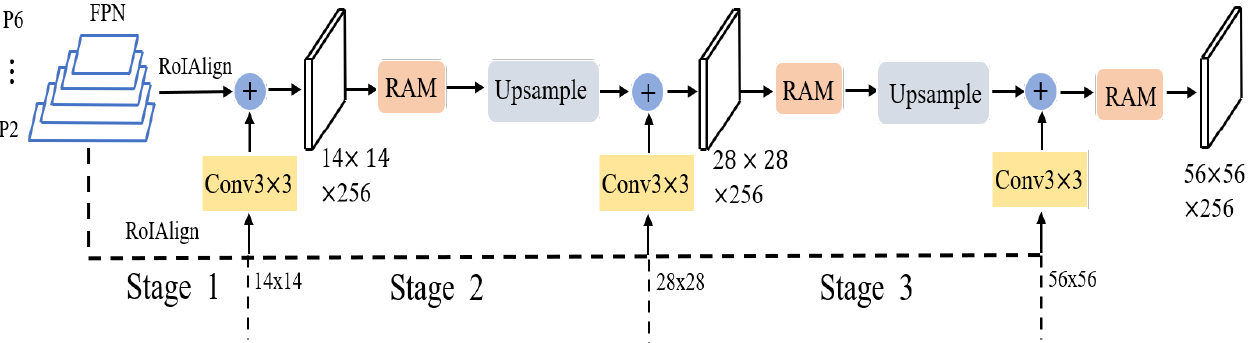
Figure 4. Framework for multiple-stage fusion. On the basis of FPN, different feature layers are extracted as the main line to provide deep semantic information. Parallel auxiliary lines with a fine-grained features complement the shallow detail information. The extracted detail features of different sizes are integrated with detail information by 3 × 3 convolution and then incorporated into the main line with deep semantic information. Each stage has a residual-aware module that obtains contextual information at different scales. These features are upsampled (bilinear interpolation) to gradually fuse higher-resolution detail information. To solve the segmentation inconsistency problem and the boundary pixel-scale imbalance problem, the BRank and Sort loss function is proposed. Higher mask quality is